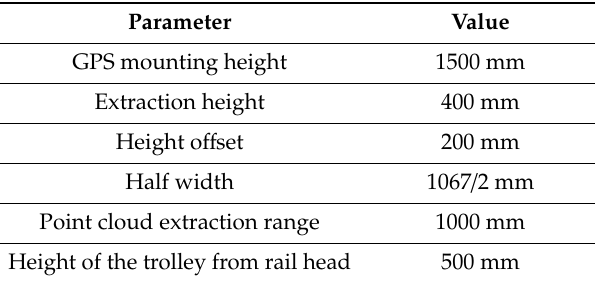
Table 2. Experiment setup